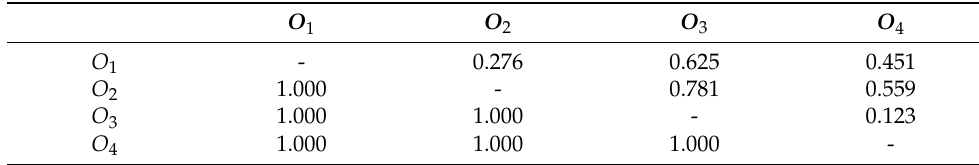
Table 20. Discordance matrix.